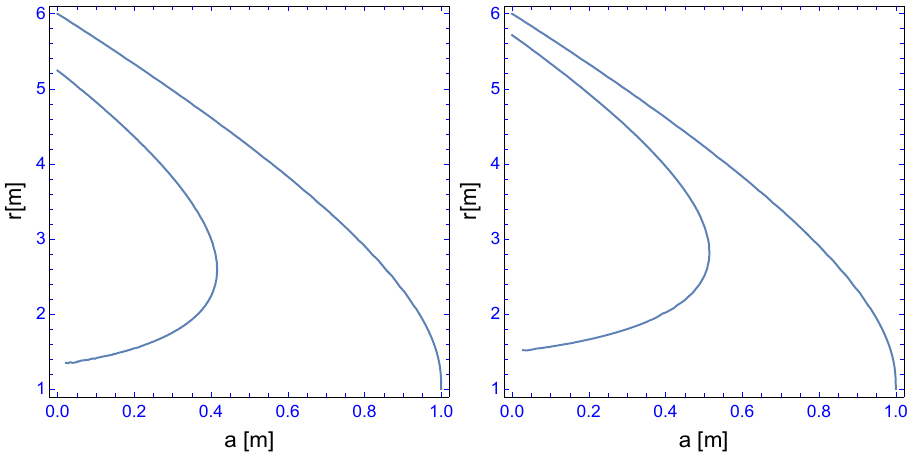
Figure 2. The position of the Innermost Stable Circular Orbit (ISCO) for n = 3 ( left panel ) and n = 4 ( right panel ) is plotted versus the rotational parameter a . The upper curve in each figure corresponds to GR and the lower curve to pc-GR. In the region to the left of the pc-GR curve, the orbits are unstable in pc-GR; above and to the right, the orbits are stable. For small values of a , the ISCO in pc-GR follows more or less the one of GR, but at smaller values of r . From a certain value of a on, stable orbits are allowed until the surface of the star. For n = 3, this limit is approximately a = 0.4 m 0 and, for n = 4, it is above a = 0.5 m 0 . For larger values of a , all orbits are stable in pc-GR. For the construction of the curve for n = 3, Equation (42) of [12] was used. This equation has to be modified for n = 4, which is direct. It can be retrieved from [45], where all the routines used here are openly